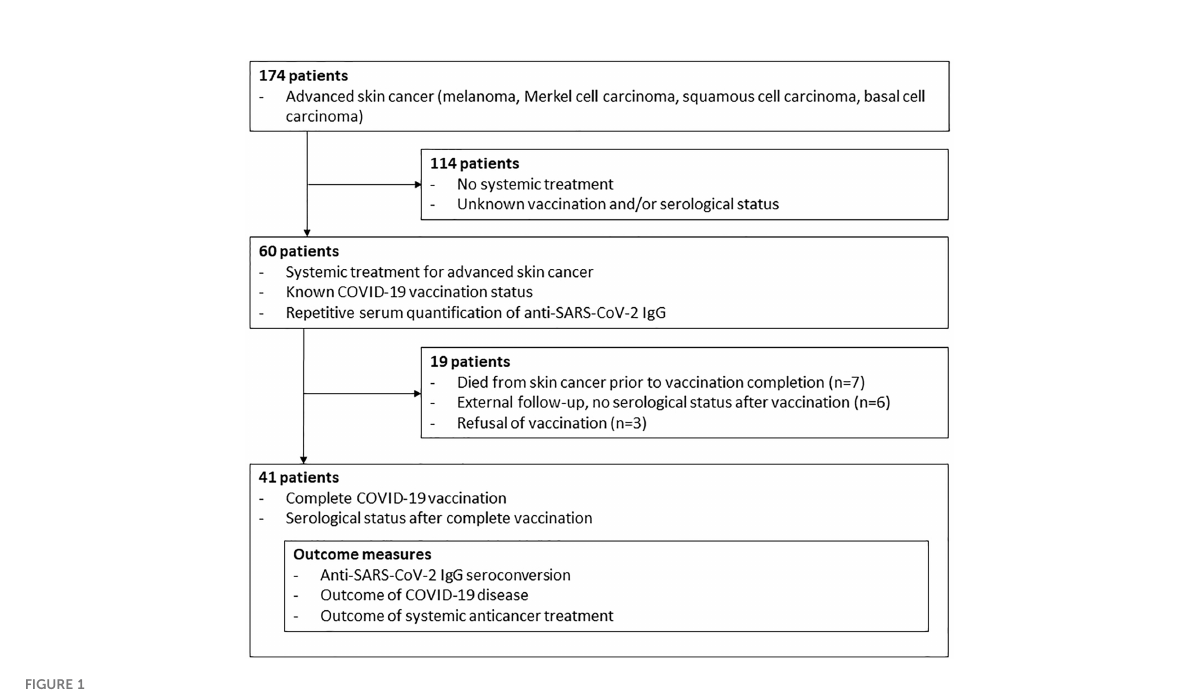
FIGURE 1 Patient